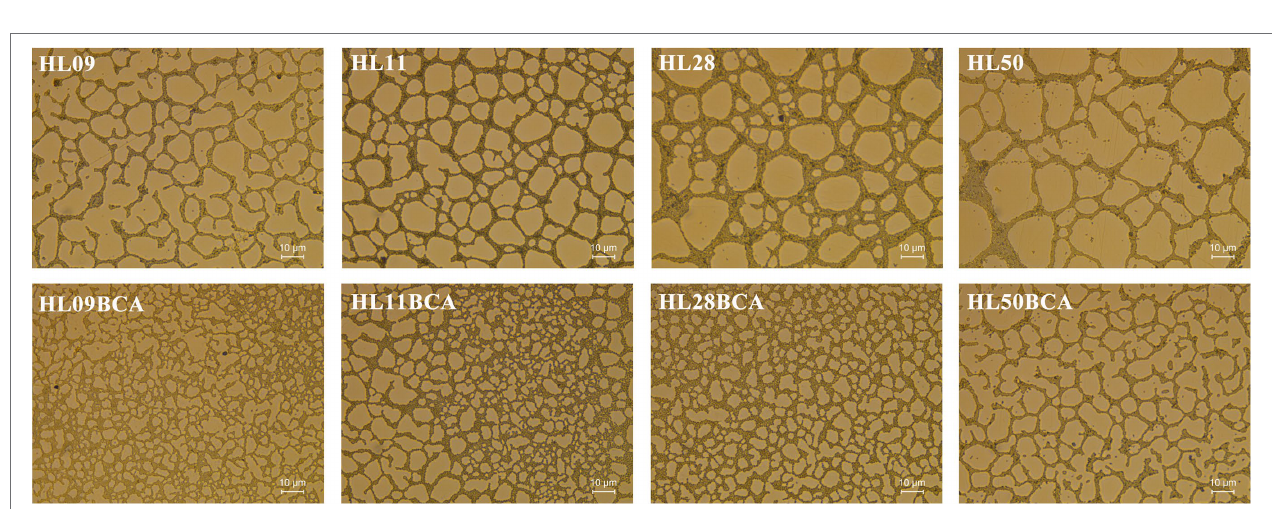
FIGURE 2 | Biofilm formation assay by microtiter plate with crystal violet staining of the wild-type strains and the BC adapted strains of Listeria monocytogenes at 37 ° C for (A) 24 h, (B) 48 h, and (C) 72 h. Surviving planktonic cells in the bacterial culture incubated at 37 ° C for (D) 24 h, (E) 48 h, and (F) 72 h. Error bars represent the standard deviation of triplicate experiments ( n = 3). The asterisk indicates a value statistically different from that of the wild-type strain, with p < 0.05.